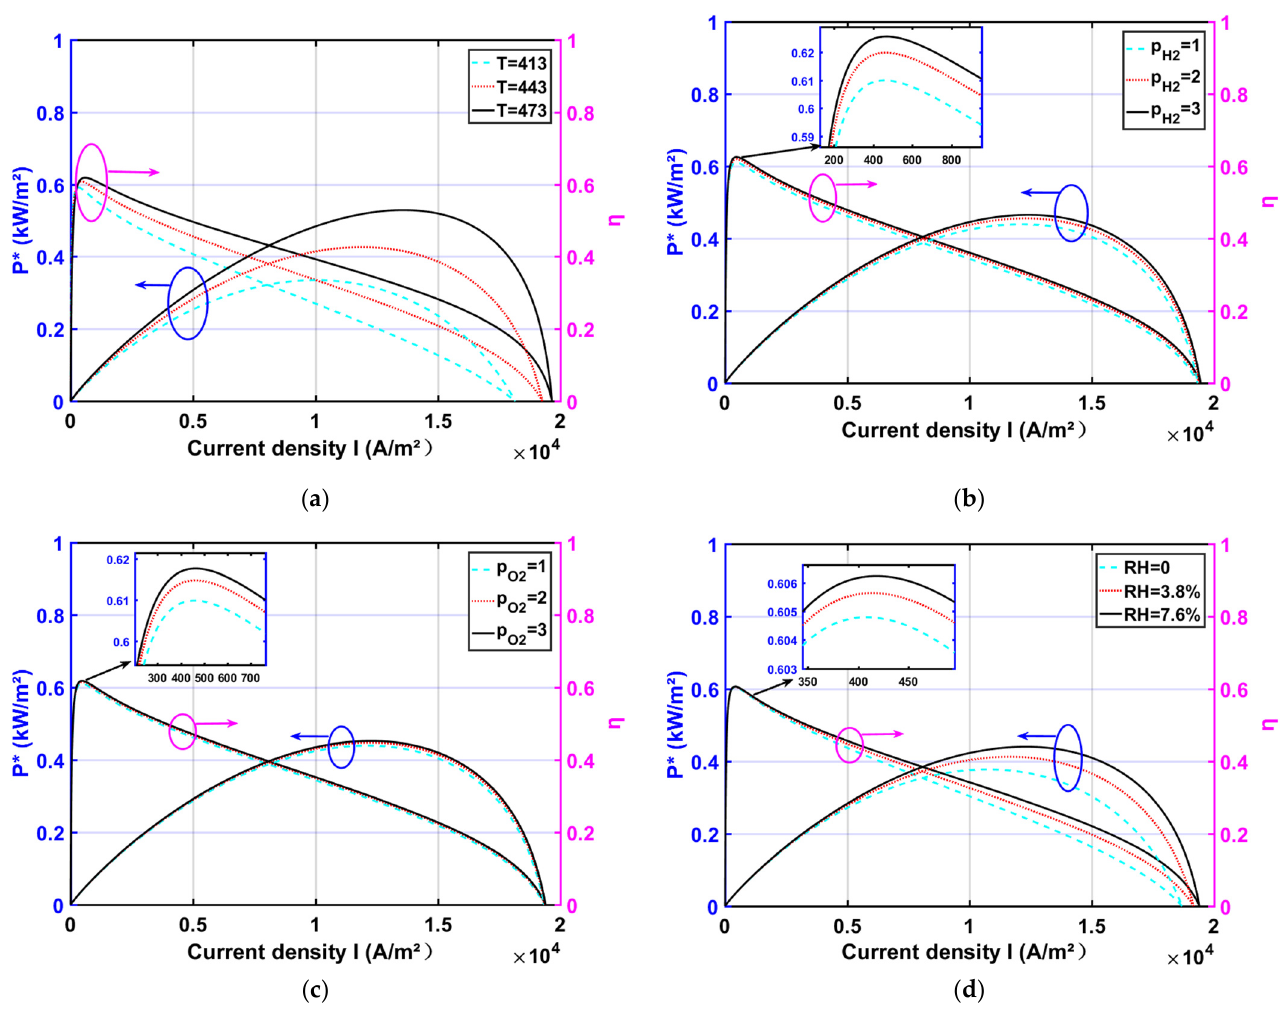
= 1 atm; (cid:1868) (cid:3016) = 1 atm; (cid:1844)(cid:1834) = = 1 atm; p = 1 atm; (cid:3118) (cid:3118) O 2 2 ; ( c ) different (cid:1868) (cid:3016) ; ( d ) different (cid:1844)(cid:1834) . ; ( c ) different p O ; ( d ) different RH (cid:3118) (cid:3118) 2 2